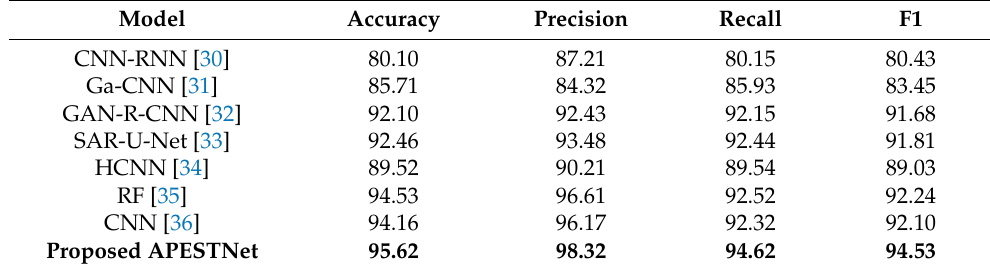
Table 3. Comparative Analysis of Proposed Model.